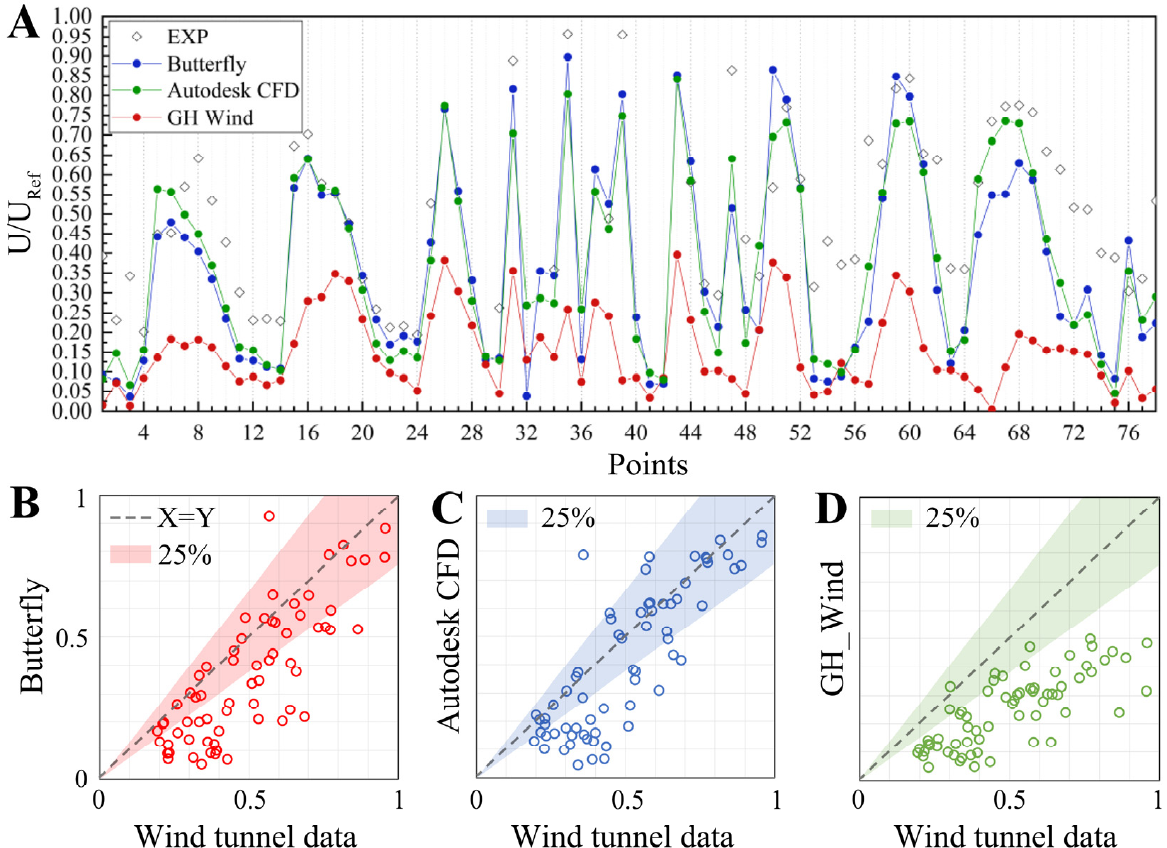
Figure 14. ( A ) The ratio of the wind velocity corresponding to the measured points on the horizontal plane of pedestrian level to the reference velocity (6.65 m/s) when the wind direction is 45 ◦ ; correlation analysis of the simulation results obtained by ( B ) Butterfly, ( C ) Autodesk CFD, and ( D ) GH_Wind and wind tunnel data, respectively. Shaded regions in ( B – D ) mark the prediction envelopes with allowable errors of less than 25%.